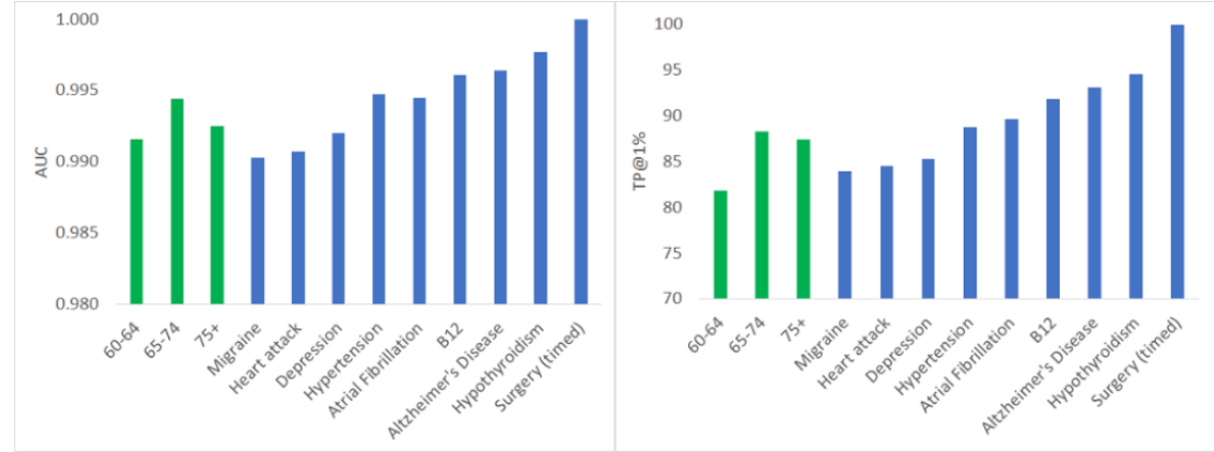
Figure 2. Area under the receiver operating characteristic curve (AUC, left) and the true positive rate at a 1% false-positive rate for separating the patient cohort from each of the control